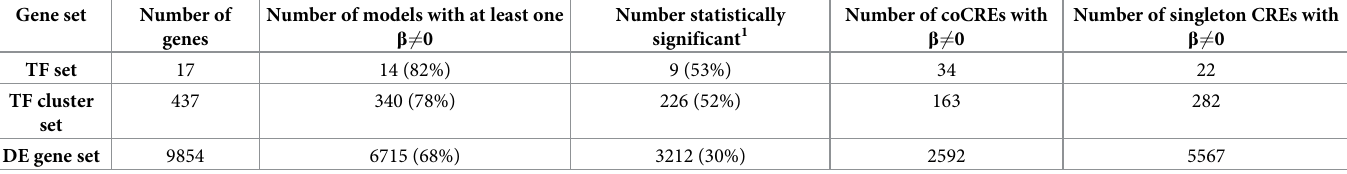
Table 2. Generation of